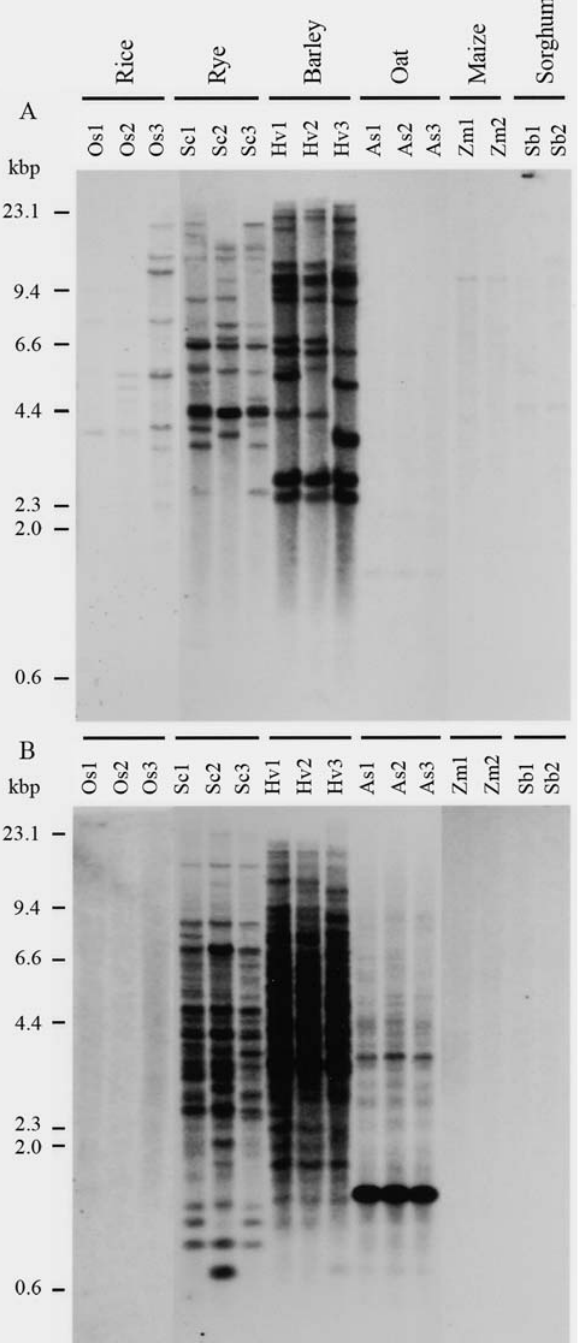
Figure 3 - DNA blot analysis of MULE transposases in six grass species. Abbreviations of the accessions are as follows: Os1 - Oryza sativa ssp. ja- ponica cv. Nipponbare; Os2 - ssp. javanica accession no. 242 (National Institute of Genetics (NIG), Japan); Os3 - ssp. indica accession n. 101 (NIG); Sc1 - Secale cereale cv. Haruichiban; Sc2 - cv. King II; Sc3 - cv. Steel; Hv1 - Hordium vulgare cv. Ingrid; Hv2 - cv. Betzes; Hv3 - cv. Suwon6; As1 - Avena sativa cv. Brooks; As2 - cv. Kanota; As3 - cv. Ogle; Zm1 - Zea mayz cv. Woody corn (Sakata Seed corporation (SSC), Japan); Zm2-cv.Popcorn(SSC);Sb1- Sorghumbicolor accessionno.PI244057 (National Genetic Resources Program, ARS (NGRP), USDA); Sb2 - ac- cession no. NSL 92562 (NGRP). DNA digested with Hin d III was hybrid- ized with probes: (A) MoTU-32 (subclass I) and (B) MoTU-12